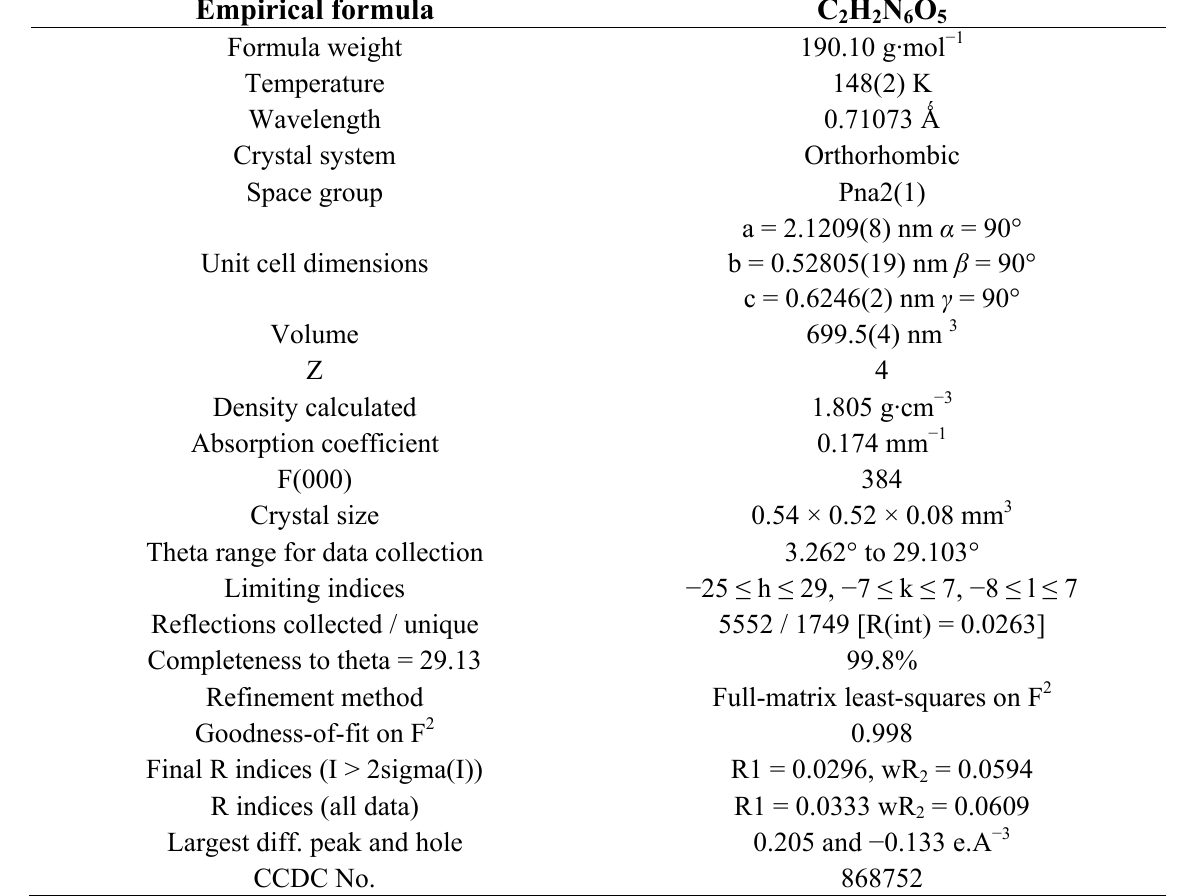
Table 1. Crystal data and refinement for 5-nitro-2-nitratomethyl-1,2,3,4-tetrazole ( 4 ).